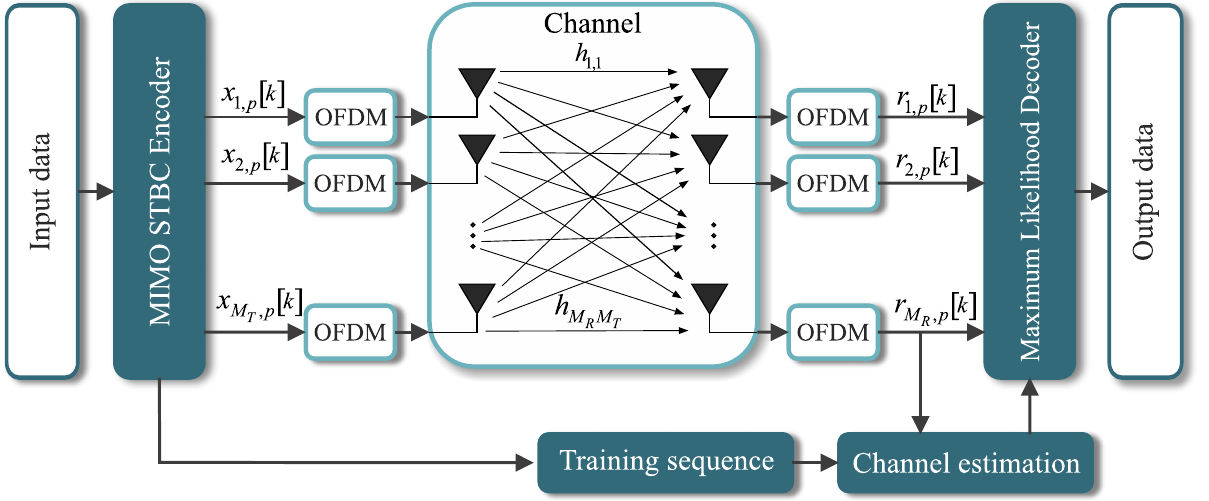
Figure 3. MIMO-OFDM model system with channel